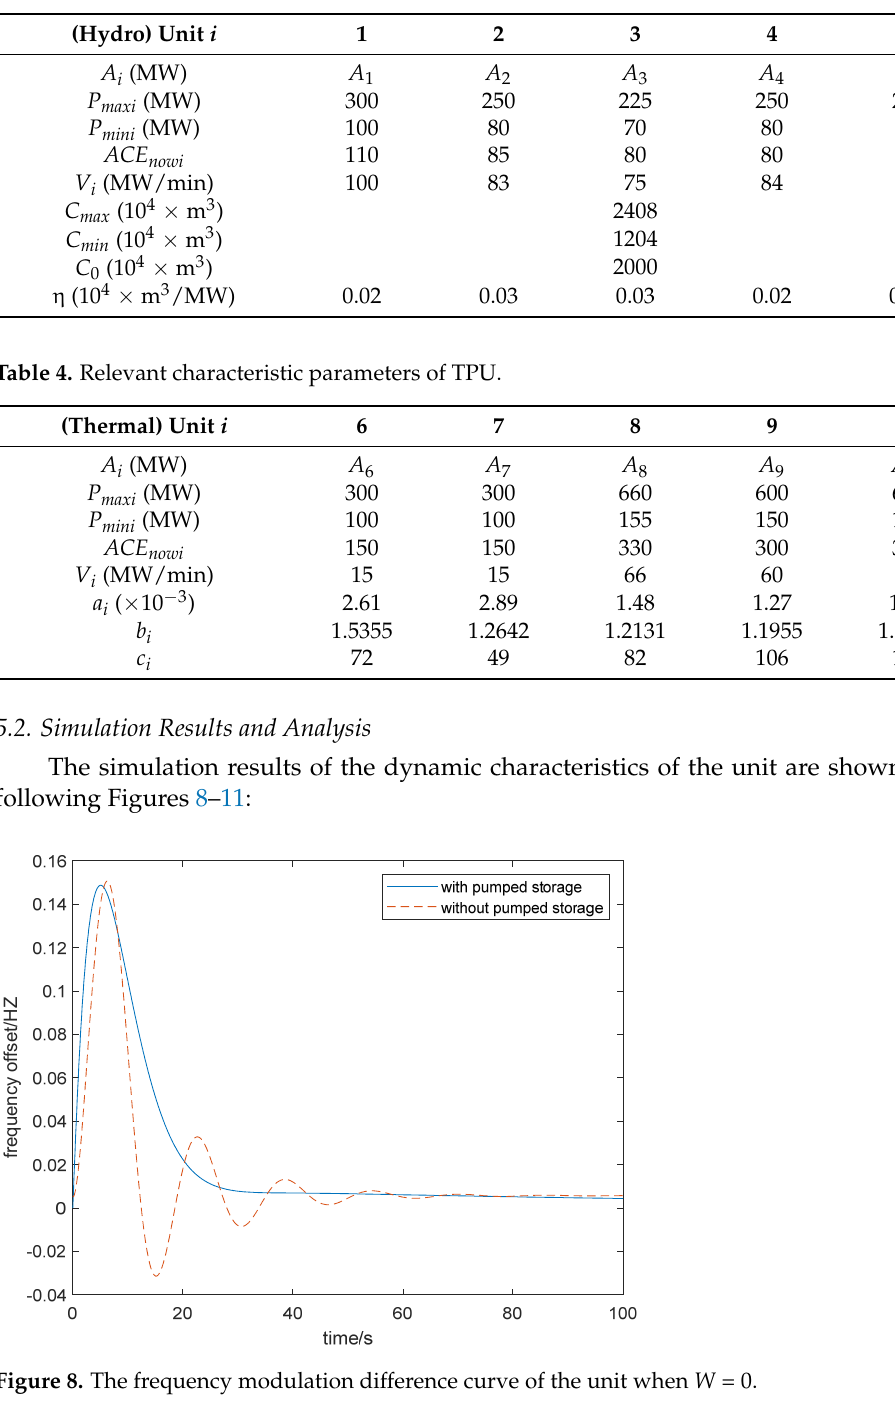
Table 3. Relevant characteristic parameters of DFPSU.